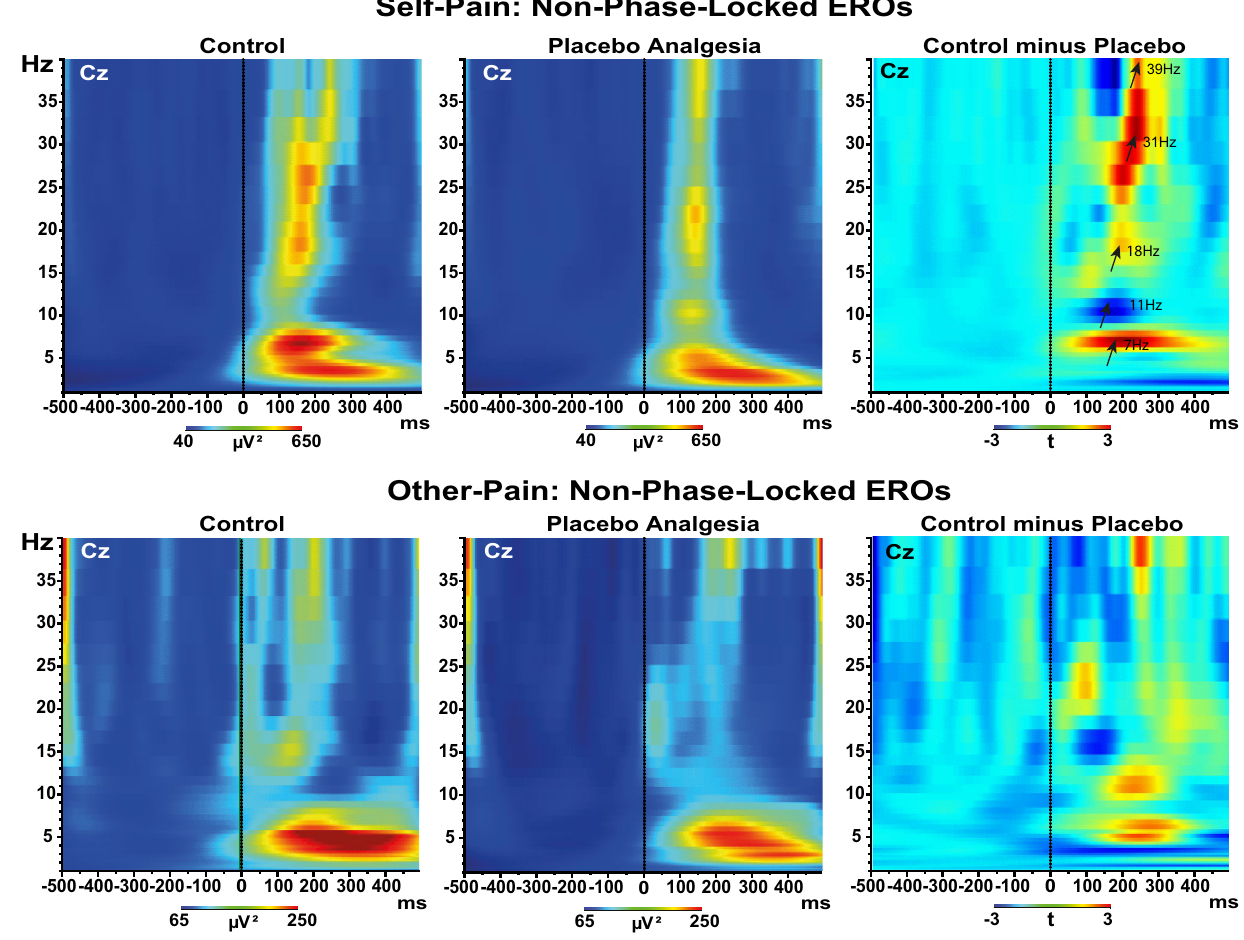
Figure 2. Grand averages across participants of single trials time–frequency (TF) estimation of non-phase locked (induced) oscillation power obtained by using the norm of the Morlet transform of EEG time-series recorded at Cz as elicited at the offset of painful electric train stimulus. Time is presented on the x -axis, and the vertical bar indicates stimulus offset at 0 ms. The frequency between 0 and 40 Hz is presented on the y -axis. Normed output spectral power values are coded on a color scale, the highest energy values appearing red and lower values blue . Data are baseline referenced, thus providing levels of positive power values relative to a reference period (from − 500 to − 50 ms). EEG changes for the Control and Placebo analgesia treatment during each self-pain (upper-panel) and other-pain (lower-panel) conditions. Right panels display the t-test differences between the two conditions. A power increase relative to baseline level can be observed in response to all stimuli during Control compared to Placebo treatments. This increase is pronounced in the self-pain between 100 and 250 ms. The maximum relative increases during the Control of TF power were at 7 Hz, 11 Hz, 18 Hz, 31 Hz, and 39 Hz, as shown by the arrows in the uppeR–Right panel. The power increases can be observed at all midline electrodes but are more assertive at central